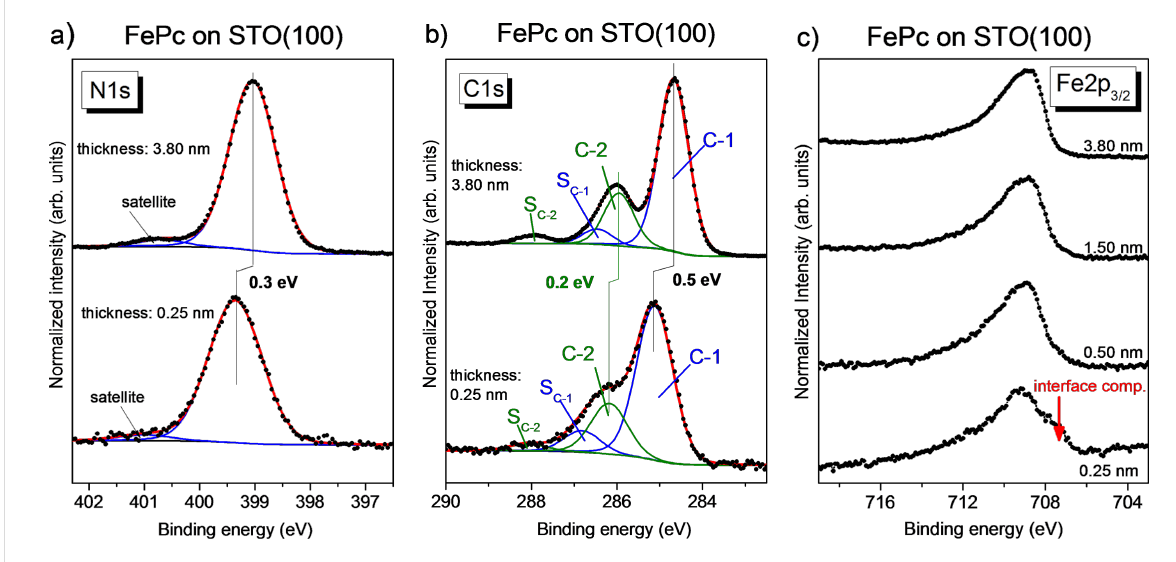
Figure 5: FePc on STO(100). (a) N 1s, (b) C 1s, and (c) Fe 2p core level spectra of multilayer films compared to a coverage of about a monolayer. The Fe 2p spectra show clearly an interface component at the lower binding energy side of the main peak (see arrow).